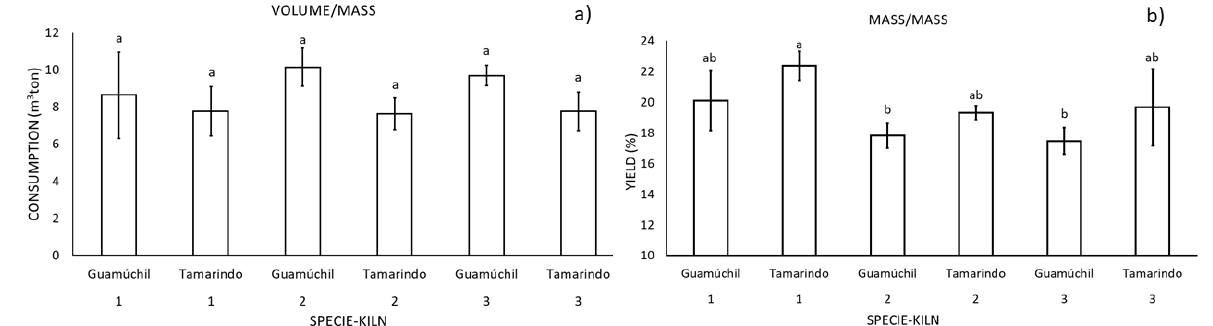
Figure 10. ( a ) Firewood consumption, and ( b ) charcoal production yield in modified Brazilian beehive kilns. Values with the same letter are statistically equal, according to Tukey test ( p ≥ 0.05).